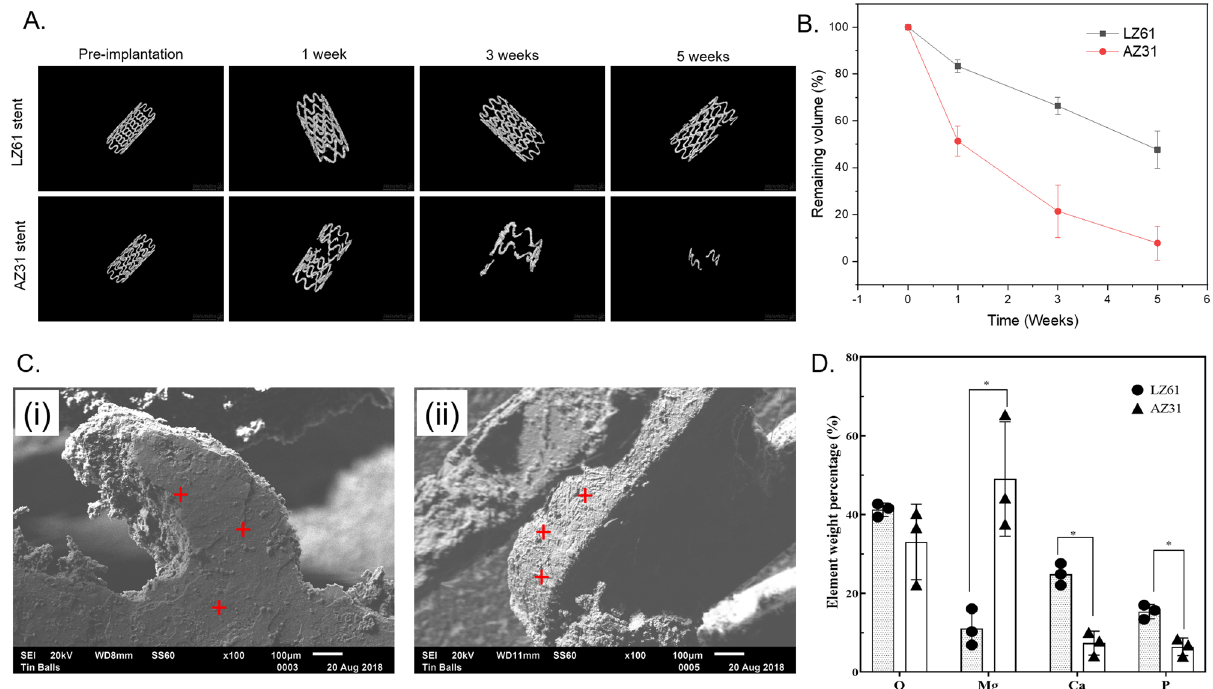
Fig. 2 In vitro degradation of LZ61-KBMS stents in bioreactor. A The 3D structure of AZ31 and LZ61-KBMS stents based on µ CT scan at different time points indicating the remaining stents after immersion in a dynamic fl ow environment. B the remaining volume of the stents calculated based on the 3D structure of AZ31 and LZ61-KBMS stents. ( n = 3). C The SEM images of the stent surface after 5 weeks of immersion in a dynamic fl ow environment